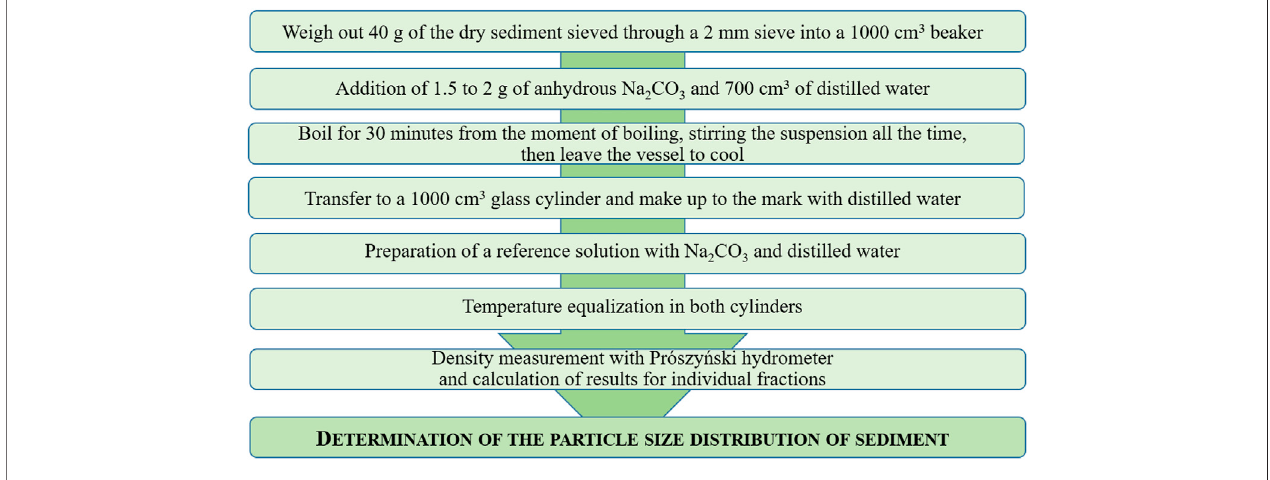
FIGURE 3 | Procedure for the determination of the particle size distribution of investigated